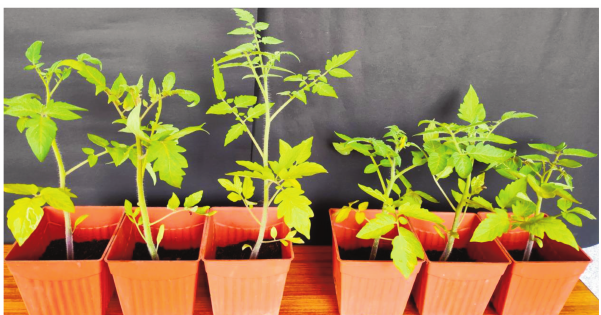
Fig. 1 ­ Lycopersicon esculentum Mill cv. Arka vikas after 14 days of application of mechanical stimuli by rubbing the 3rd internode. Left, control plants and right, treated plants.